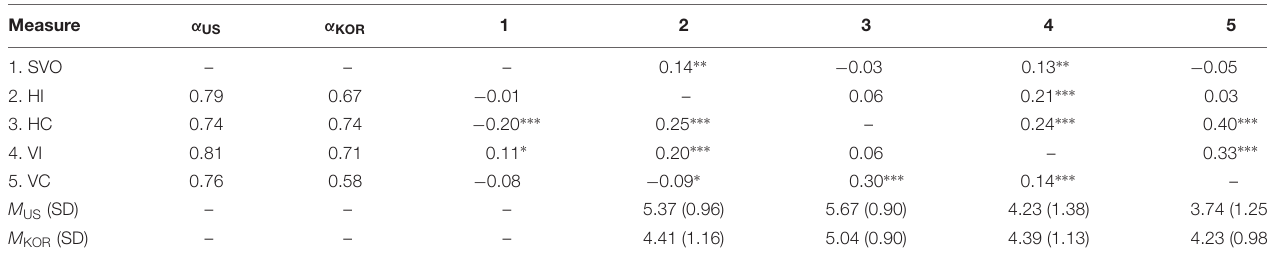
TABLE 1 | Correlations among variables, means, standard deviations, and Cronbach’s alpha for study variables separated by country. Measure α US α